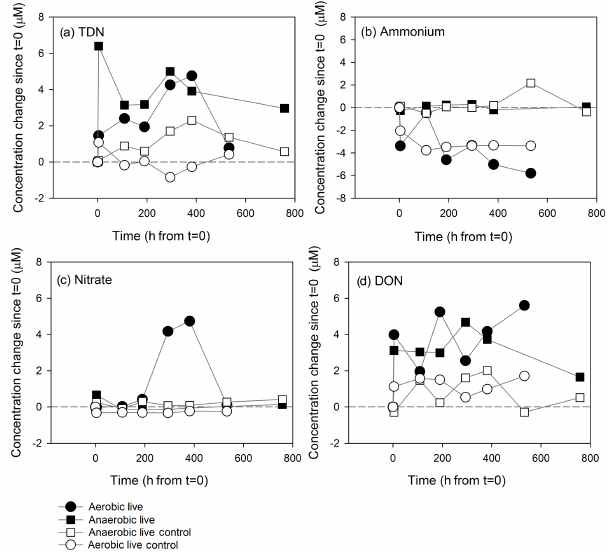
Figure 5. Time series of (a) TDN, (b) ammonium, (c) nitrate and (d) DON concentrations in anaerobic and aerobic live incubation experiments of subglacial sediments and sediment-free control ex- periments.